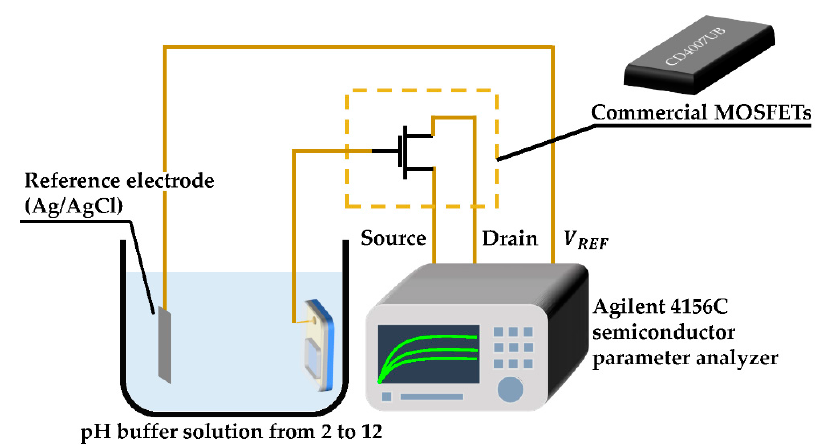
Figure 2. Measurement system of the In 0.9 Ga 0.1 O EGFET pH sensors.